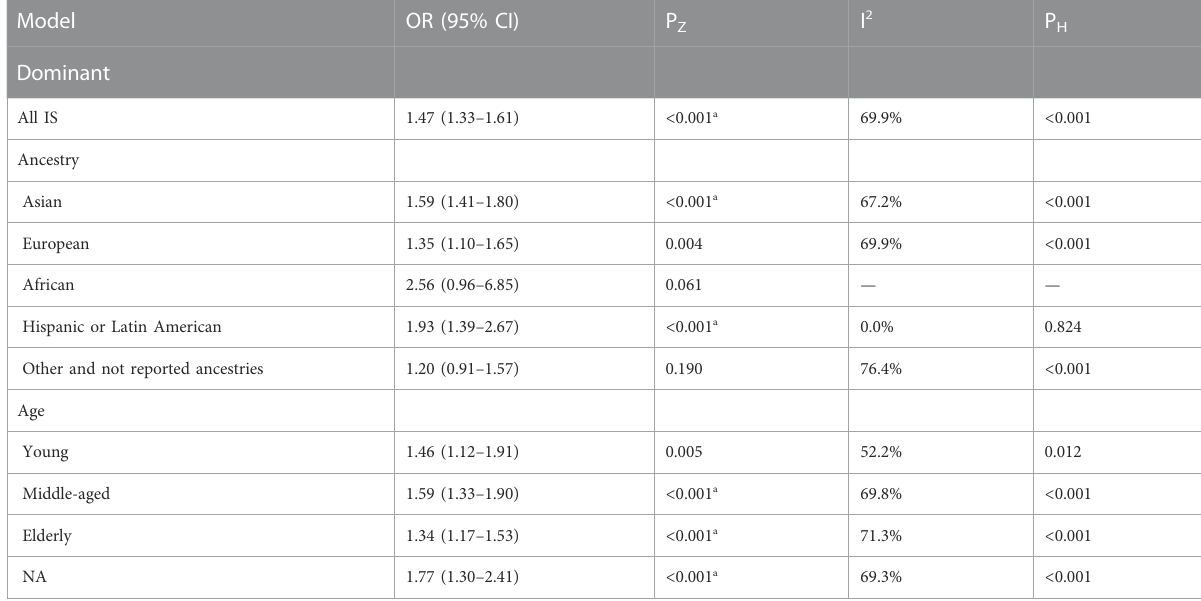
TABLE 2 Pooled odds ratios (ORs) and 95% con fi dence intervals (CIs) of the association between C677T polymorphism and stroke in the dominant model. Model